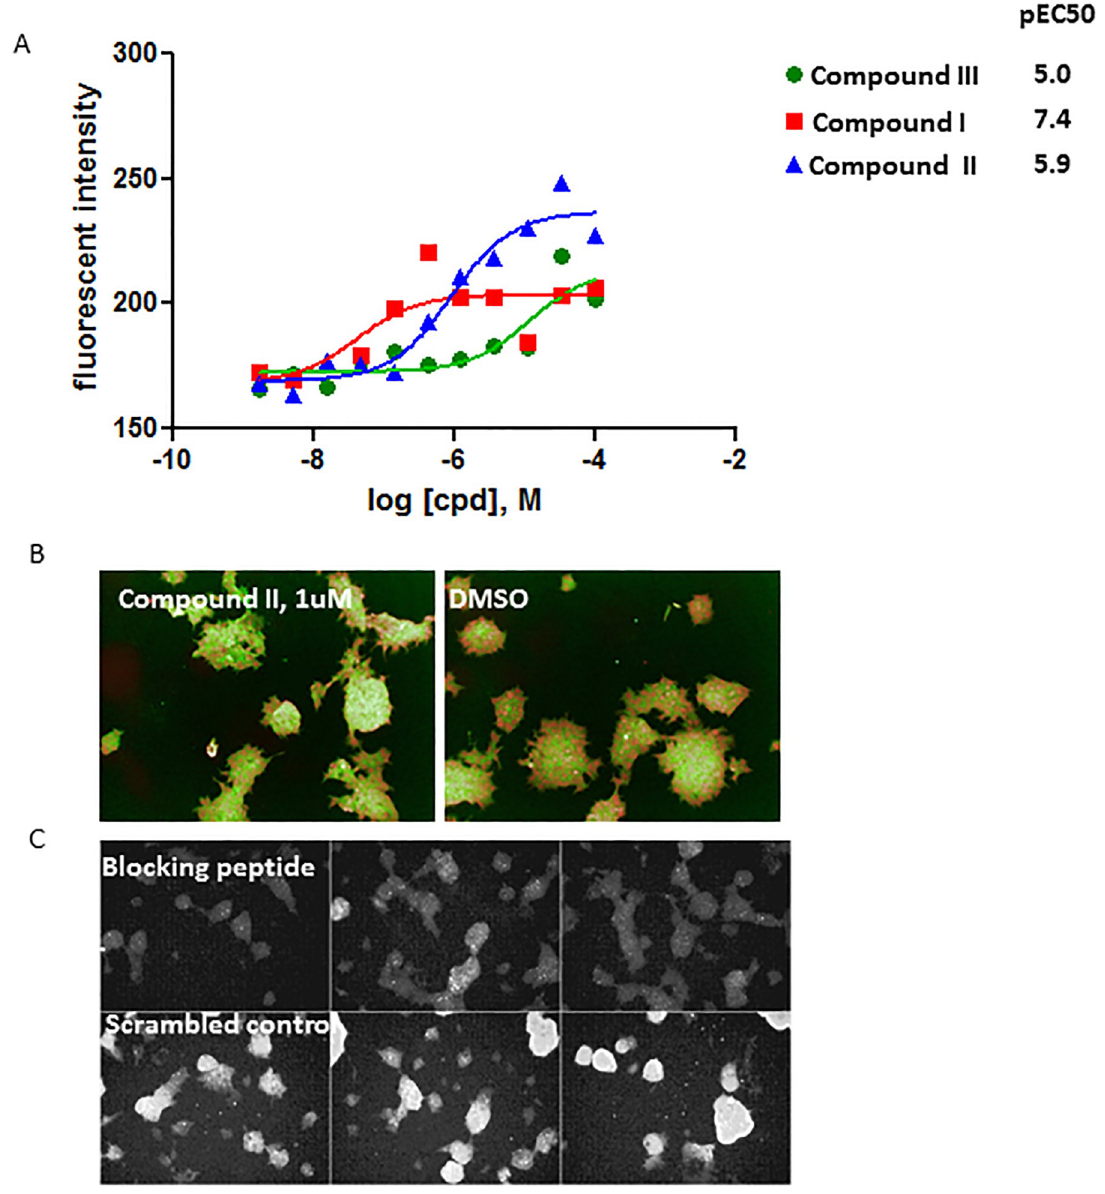
Fig 4. Confirmation of the hits from the Atoh1-NanoLuc reporter screen by immunofluorescent staining. Endogenous Atoh1 protein was detected using an Atoh1 antibody followed by fluorescent secondary antibody detection and counter stain by Hoechst 33342. The signal was quantified by Columbus imaging analysis system by measuring the average total intensity of the cytoplasmic signal per cell from 3 areas from each (A). Sample images of Atoh1 immunostaining in LS-174T cells treated with compound II and DMSO control (B). The Atoh1 staining (green) and the Hoechst 33342 counter-stain (red) is overlaid. The immuno-fluorescent signal of Atoh1 induced by compound II is eliminated by pre-incubating the antibody with a blocking peptide derived from the Atoh1 protein sequence (amino acid 325–354) (C), demonstrating the specificity of the antibody staining